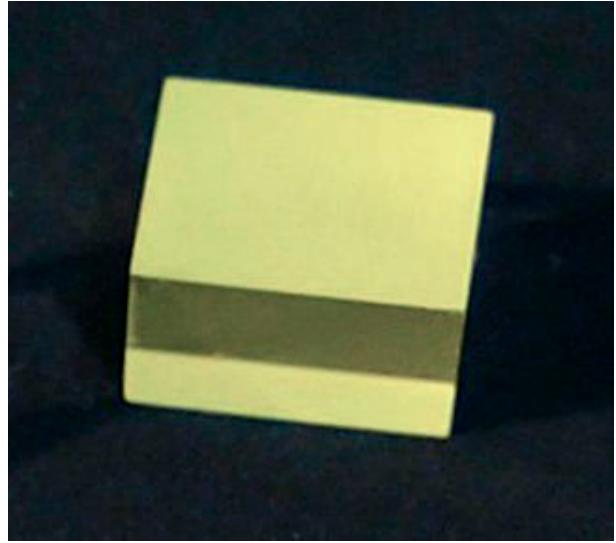
Figure 1. Photograph of a LiTaO 3 :Cr (0.005 wt%) crystal